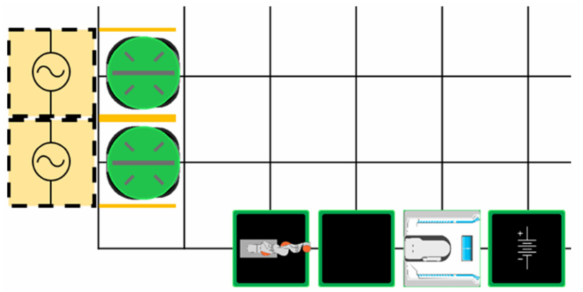
Figure 13. Self-contained charging stations.